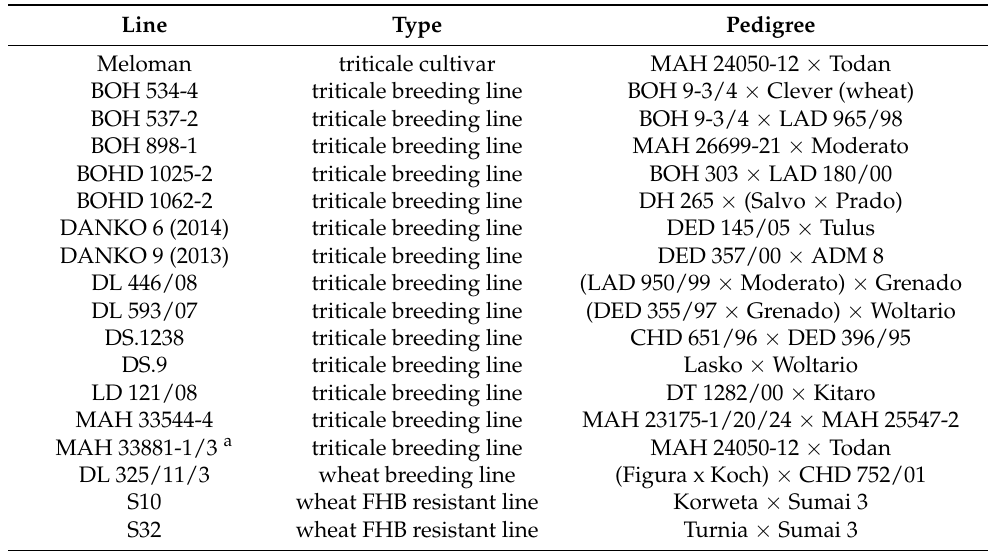
(Figura x Koch) × CHD